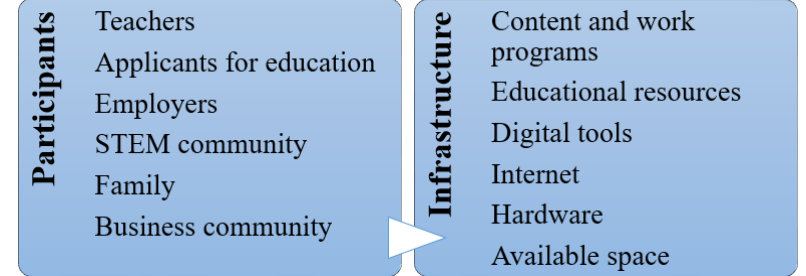
Figure 2: Components of the ecosystem of STEM